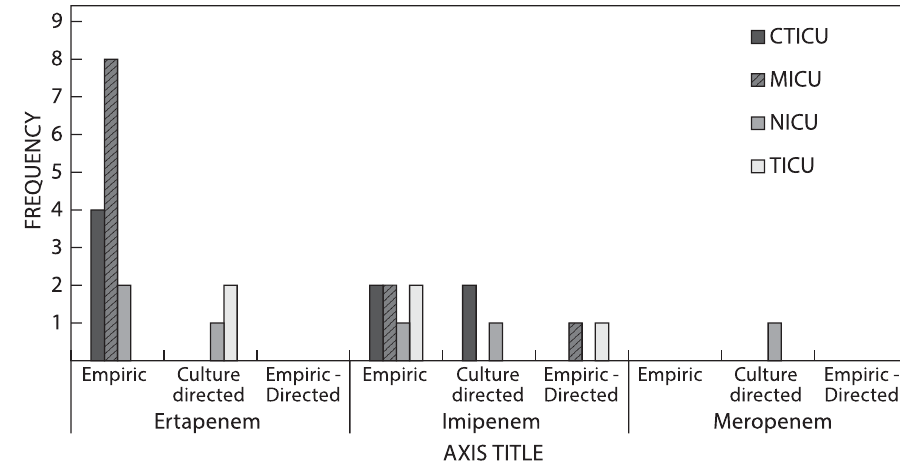
Figure 3: Number of prescriptions per ICU for carbapenems according to culture